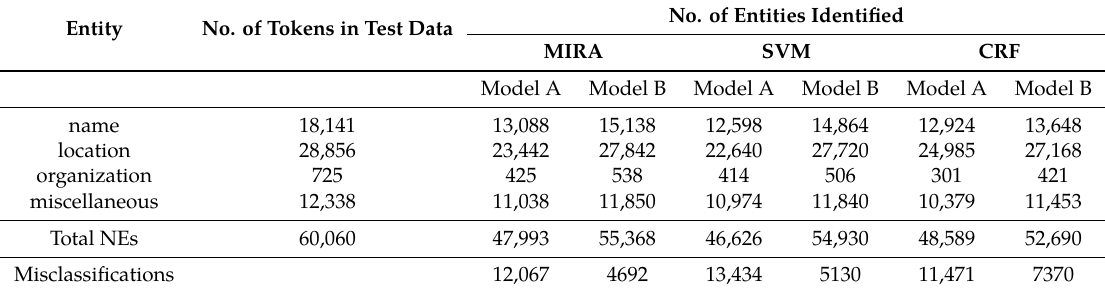
Table 11. Number of entities identified by different classifiers for Model A and Model